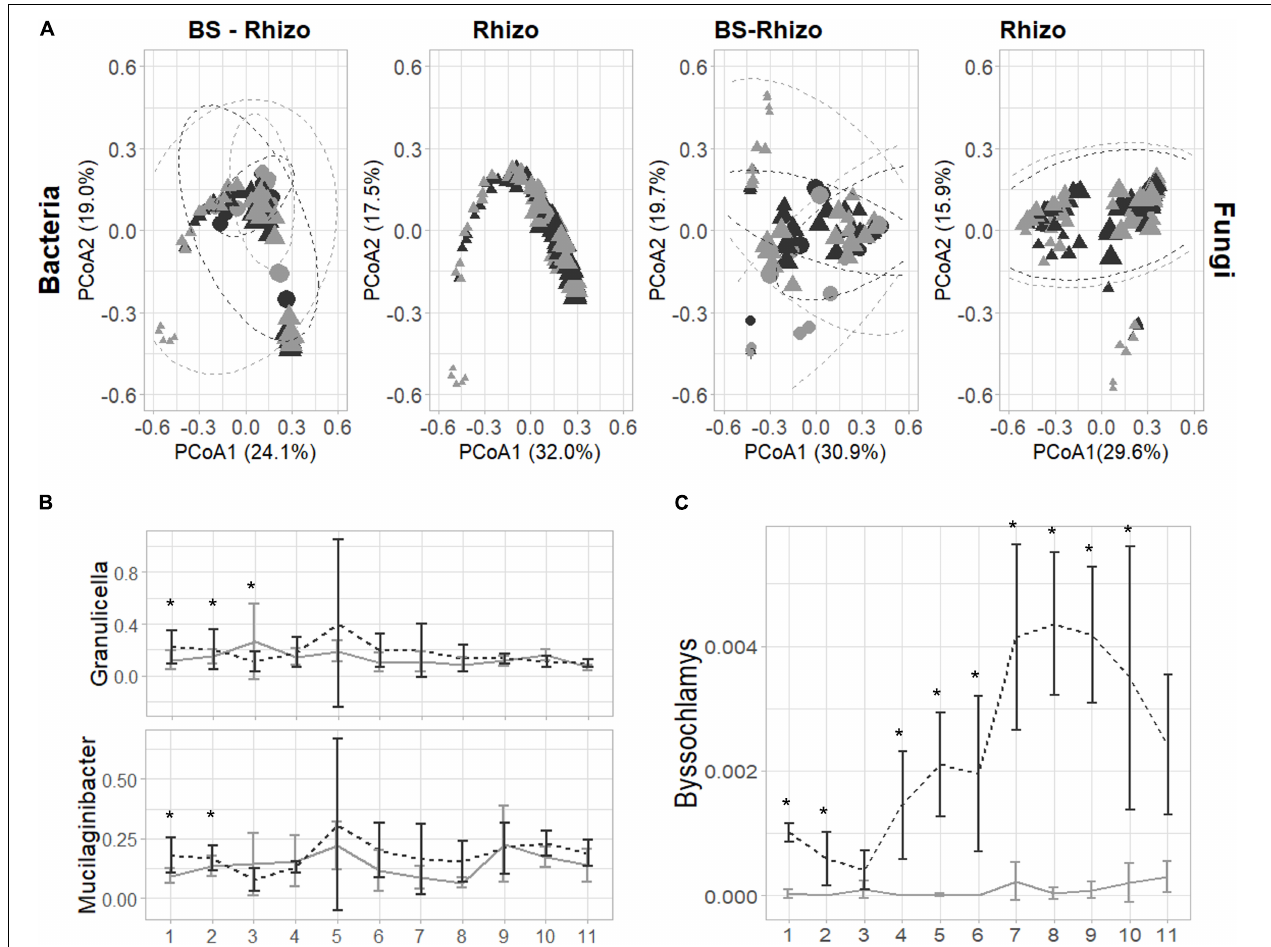
FIGURE 2 | Effect of the addition of biochar on the bacterial (the V3–V4 fragment of the 16S rRNA gene) and fungal (ITS2 gene) community of the strawberry rhizosphere over time. (A) The principal coordinate analysis plot showing that the bacterial and fungal community shift over time (symbols are getting bigger when going further in time during the experiment). Only minor effects of the addition of biochar can be observed on the bacterial community (left), while for the fungal community (right), an effect of the addition of biochar can be identified. (B) Bacterial genera are consistently increased by the addition of biochar in the first 2–3 weeks of the experiment. (C) The fungal genus Byssochlamys is consistently increased in the strawberry rhizosphere due to the addition of biochar. For all plots, samples taken from PS are indicated in light gray, while biochar-amended PS is indicated in black. Statistical significances are indicated with an asterisk (* p <